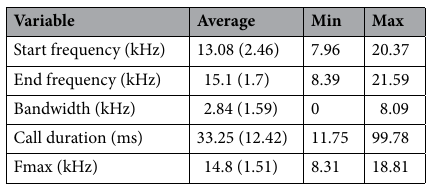
Table 3. Mean (standard deviation in parenthesis), minimum, and maximum social call parameters from 98 recorded call files containing 263 hoary bat ( Lasiurus cinereus ) social